Question: Name the type of graph shown.
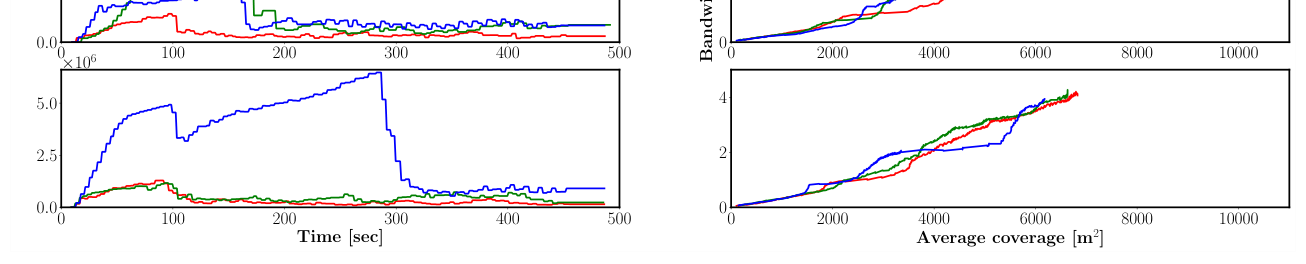
Answer: line